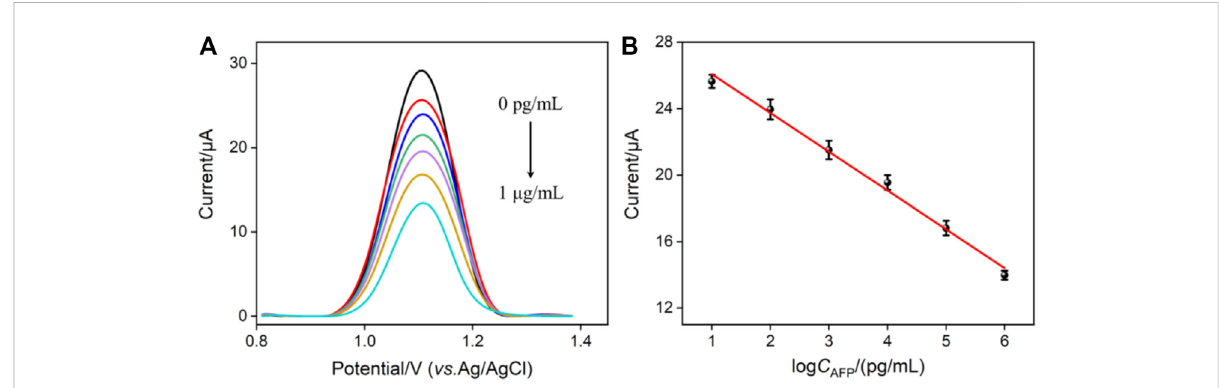
FIGURE 4 (A) DPV curves of the immunosensor in the presence of different concentrations of AFP. (B) Corresponding calibration curve. Error bars represent the standard deviation of three measurements. The electrolyte is 0.01 M PBS (pH = 7.4) containing 0.5 mM Ru (phen) 3 2+